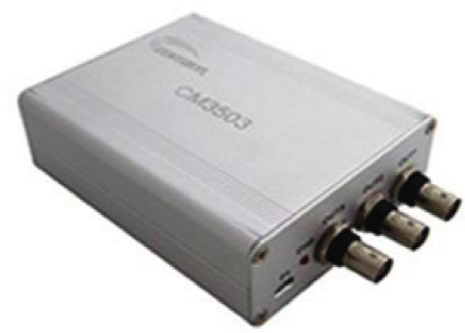
Figure 8: CM3503 ™ three-channel signal conditioner.